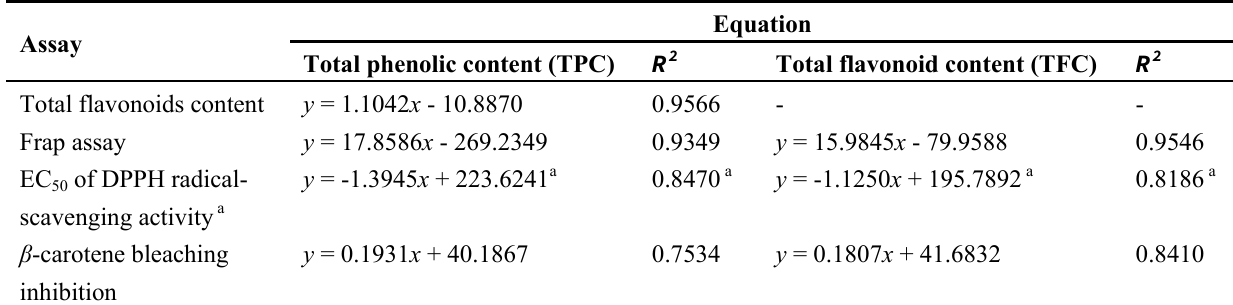
Table 3. Correlations established between total phenolics and flavonoids with antioxidant